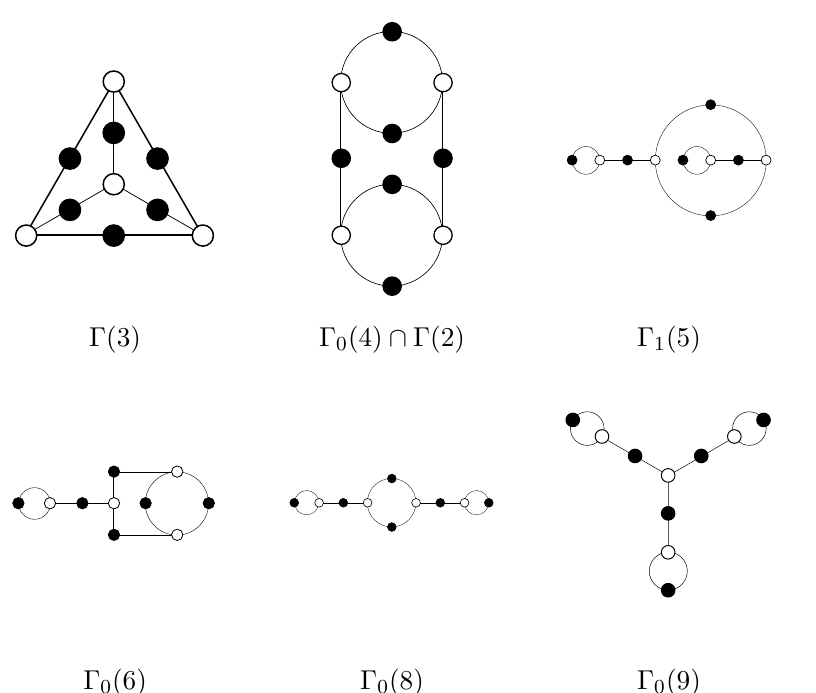
Figure 2. The dessins d’enfants associated to the six Strebel points of the SU(2), N f = 4